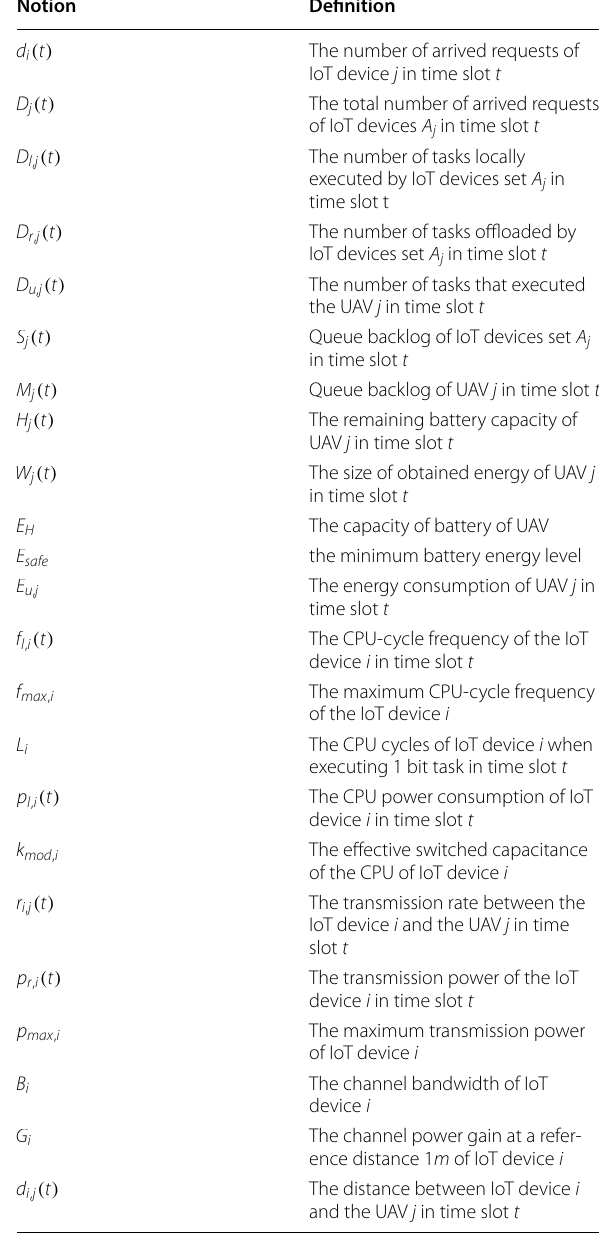
Table 1 Notations and